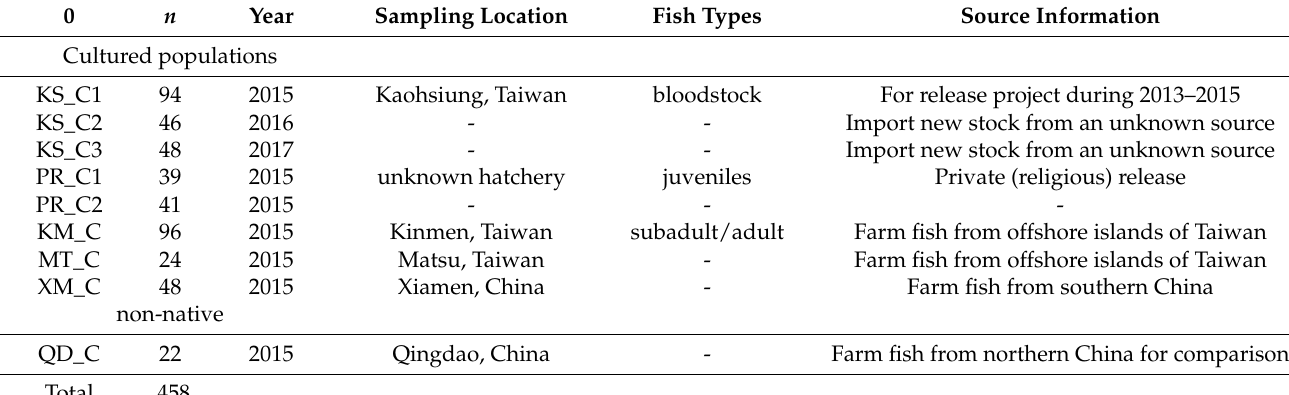
Figure 1. Sampling, hatchery, and stock enhancement information for black sea bream. Table 1. Summary of sample information. n = number of